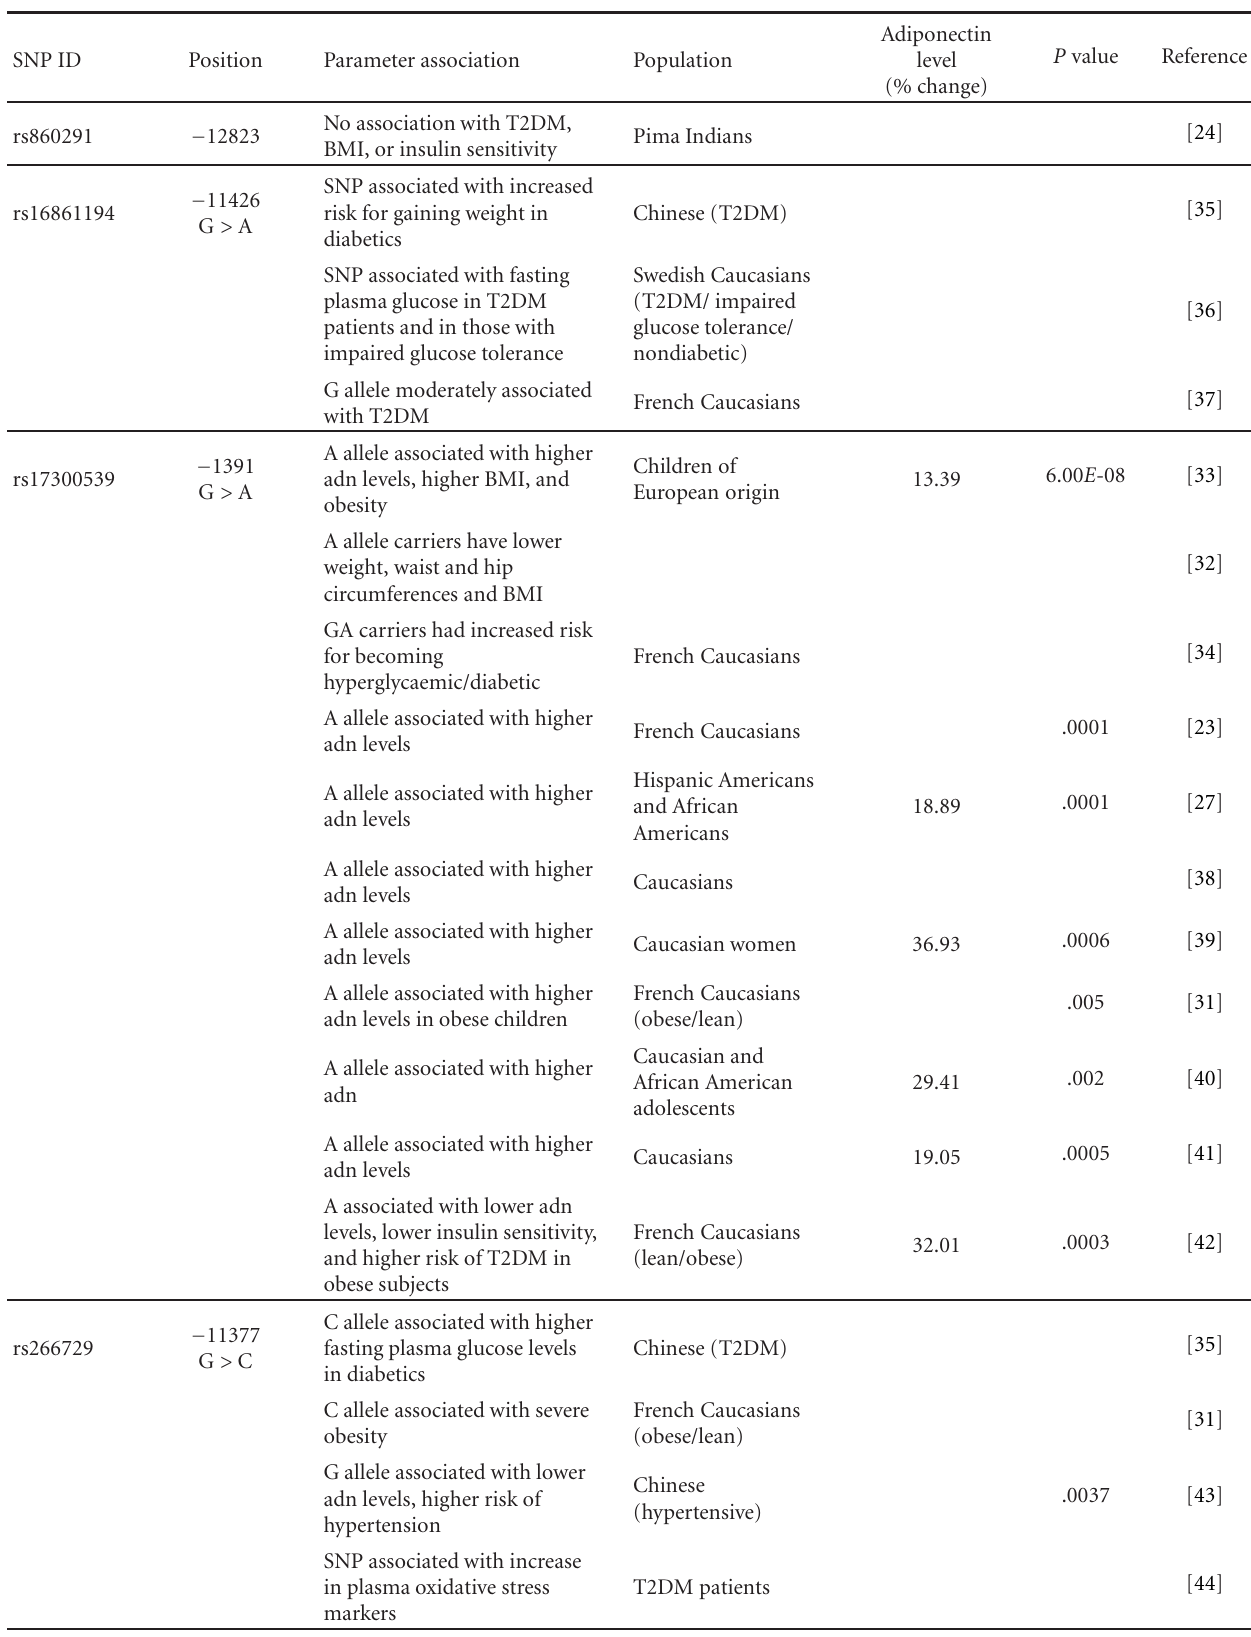
Table 1: SNPs in the adiponectin gene